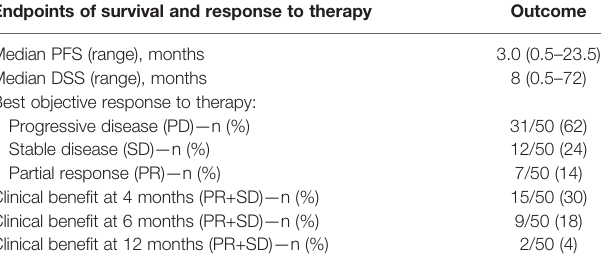
TABLE 2 | Analysis of activity of Gem/Cape chemotherapy.